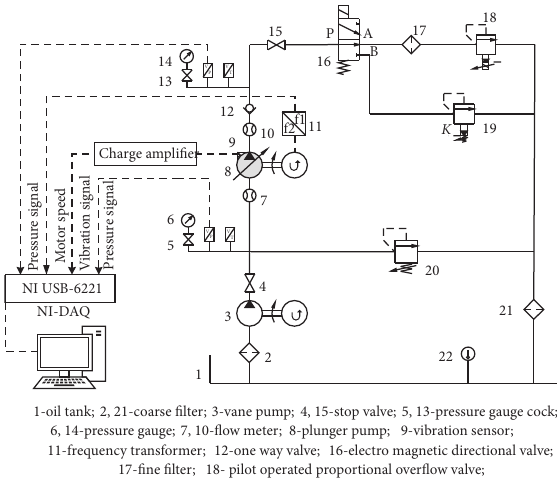
Figure 6: Principle diagram of the test system.